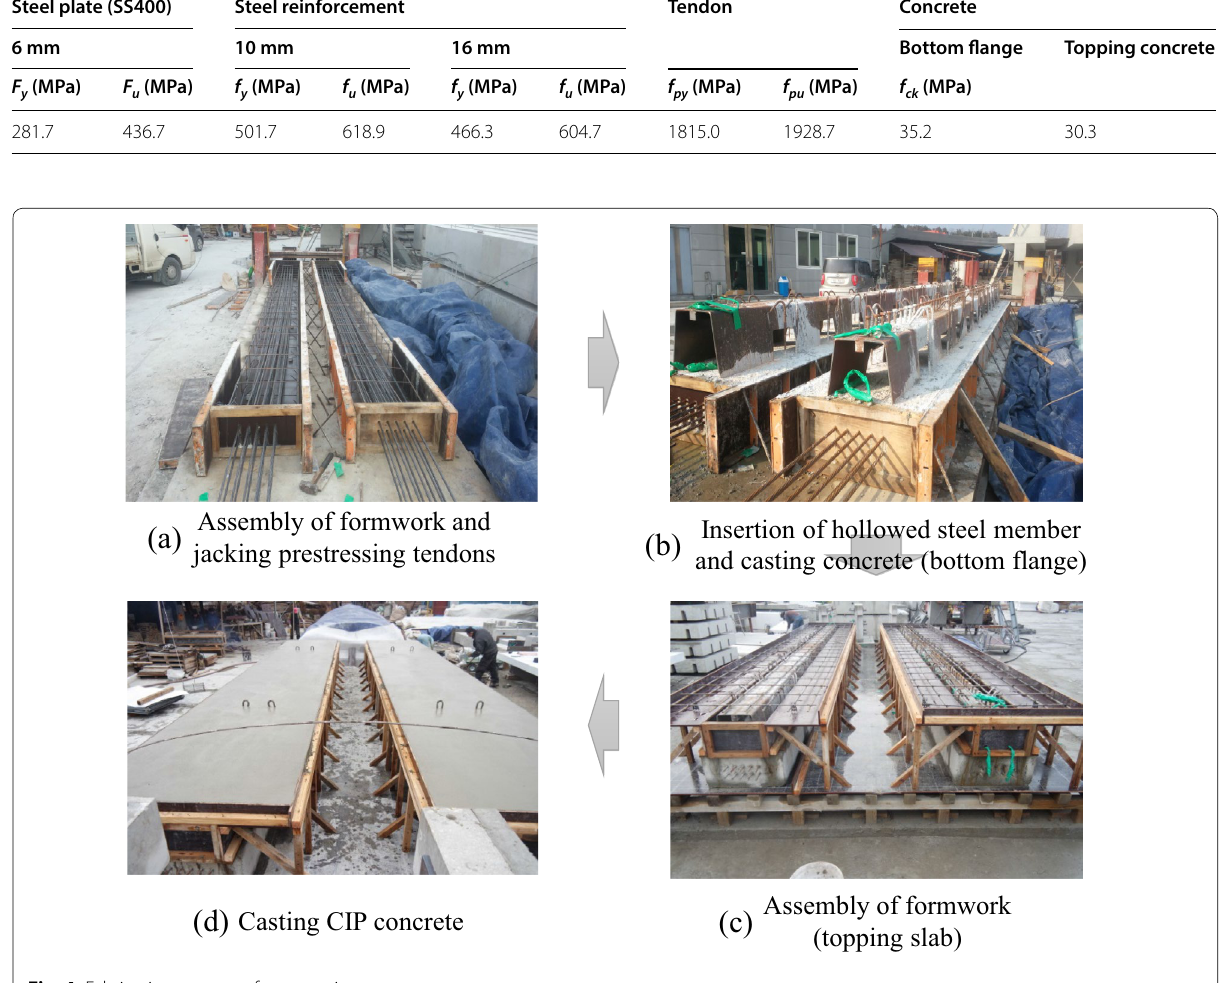
Fig. 4 Fabrication process of test